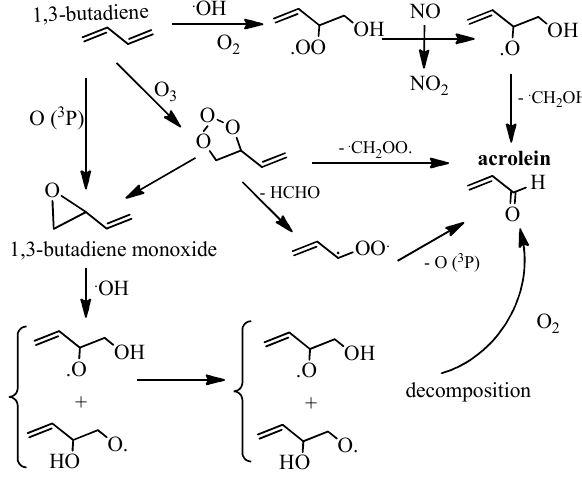
Scheme 1. Acrolein formation from 1,3-butadiene oxidation. 20